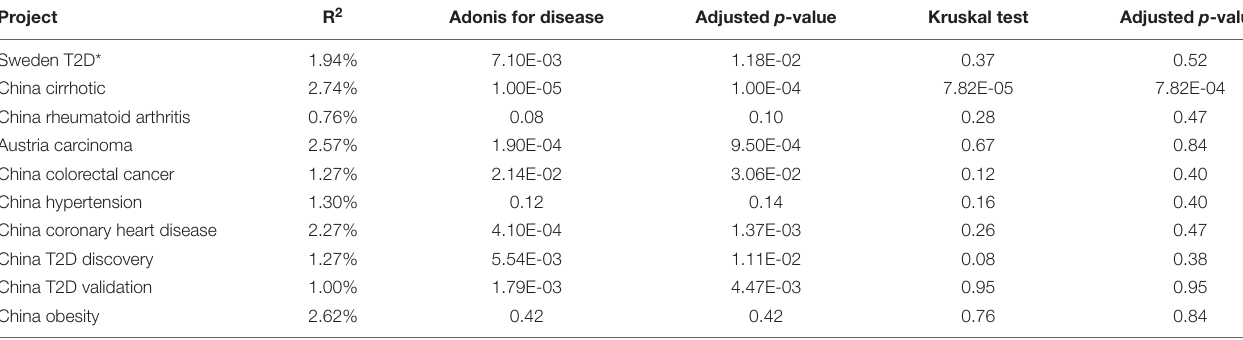
FIGURE 3 | Gut virome characterized by beta diversity in the included projects. (A) left: Principal coordinates analysis plot of the cirrhosis project. Each ellipse represents a cohort, and the point connected by the straight gray lines represents the centroid. (A) Right: Boxplot of the distance to the centroid. A significant difference in the distance to the centroid was found between the two groups. (B) Left: Principal coordinates analysis plot of the hypertension project. (B) Right: Boxplot of the hypertension project with comparison for each pair of the three groups. Healthy (Heal.), Cirrhotic (Cirr.), Prehypertension (Preh.), Hypertension (Hype.). TABLE 1 | Beta diversity for measuring the sample distance in projects with a case–control